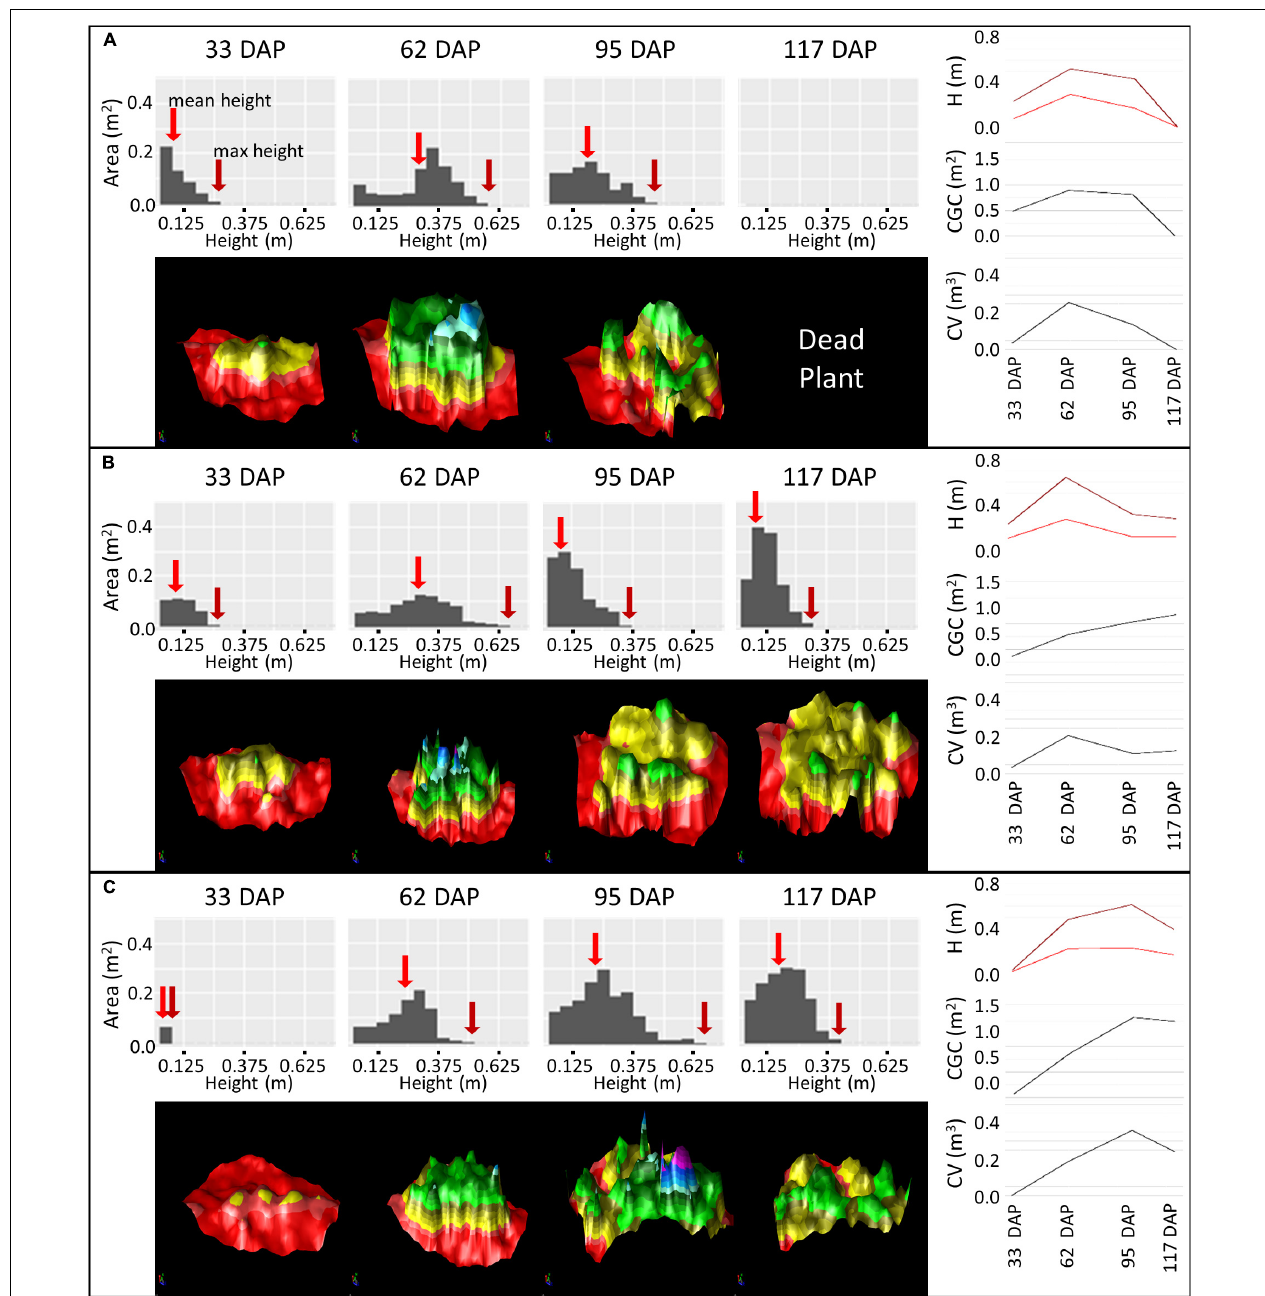
FIGURE 9 | Monitoring Canopy Volume (CV), Canopy Ground Cover (CGC) and Plant Height (H) over the growing season using difference models of three varieties: Nadine (A) , Bonnie (B) and Bounty (C) from 33 to 117 days after planting (DAP). Histograms represent the height distribution of the corresponding difference model. Maximum height is indicated with a dark red arrow and mean height with a medium red arrow. The difference model is color coded based on height, with red ( < 0 cm, soil), yellow (0–20 cm), green (20–40 cm), blue (40–60 cm), and purple ( > 60